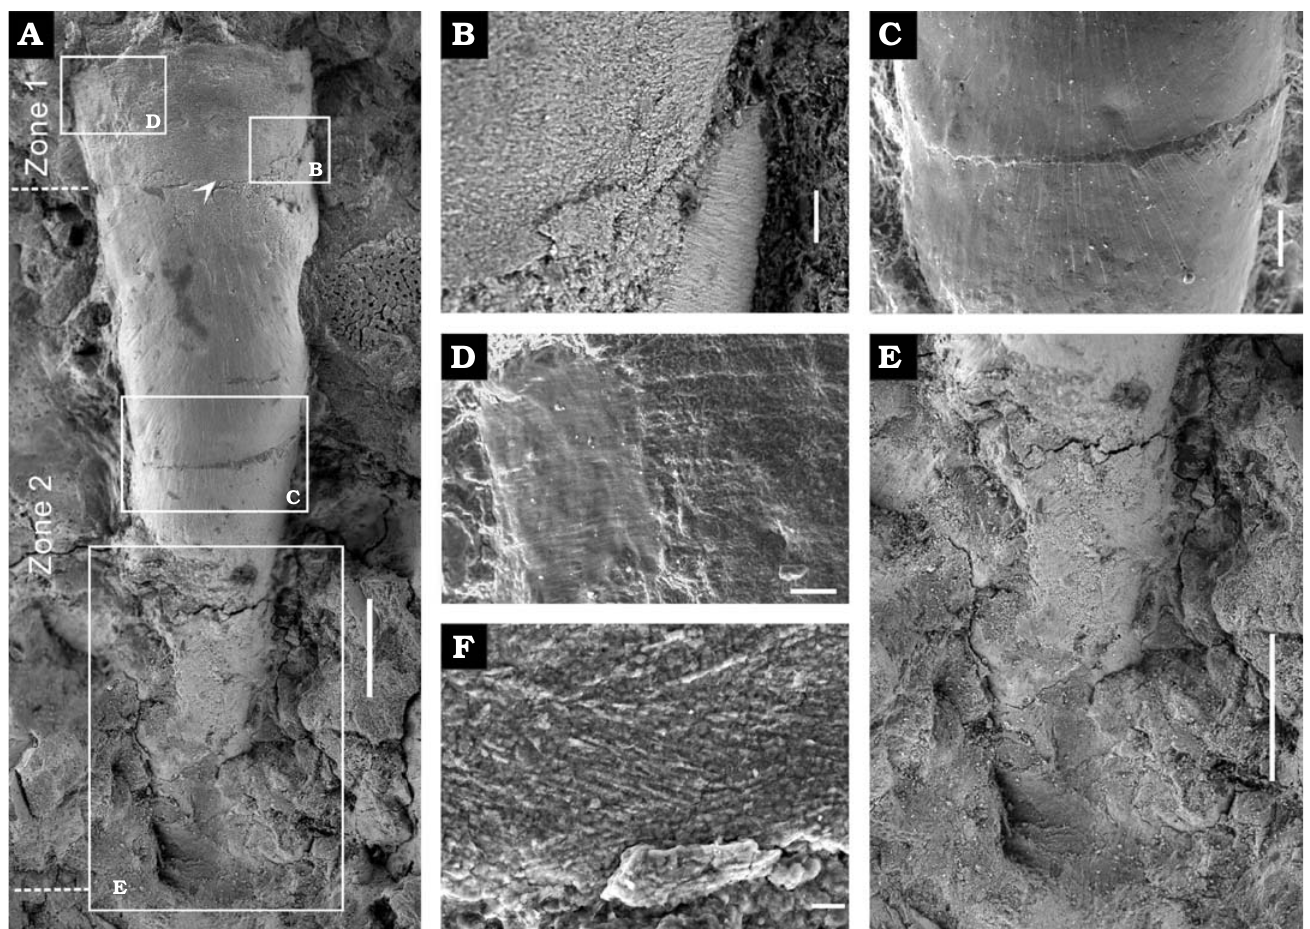
Fig. 8. Internal mould of the conch of cupithecid hyolith Cupitheca convexa sp. nov. (NIGPAS 166334) from the Manto Formation (Cambrian Stage 4/5) in the Zuojiawu section of Tangshan, China. A . General view. B . Boundary between presumed protoconch and the rest of the shell. C . Transverse lines pre- served on the surface of the conch. D . Conch covered with longitudinal to sub-radial ornament and mechanical compression forming a transverse ridge-like structure. E . Apical portion. F . Lamellar-fibrillar structure (indicated by white arrow in A). Scale bars: A, E, 200 μ m; B, 20 μ m; C, 2 μ m; D, 50 μ m; F, 5 μ